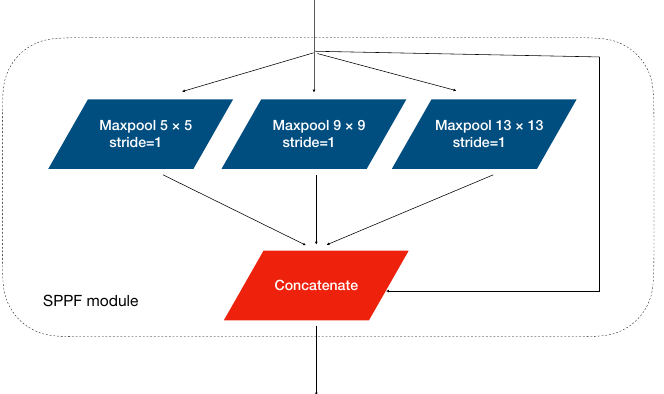
Figure 3. The SPPF module: it divides the input tensors into four channels, performs maximum pool- ing operations respectively, and then fuses the information output through the concatenate